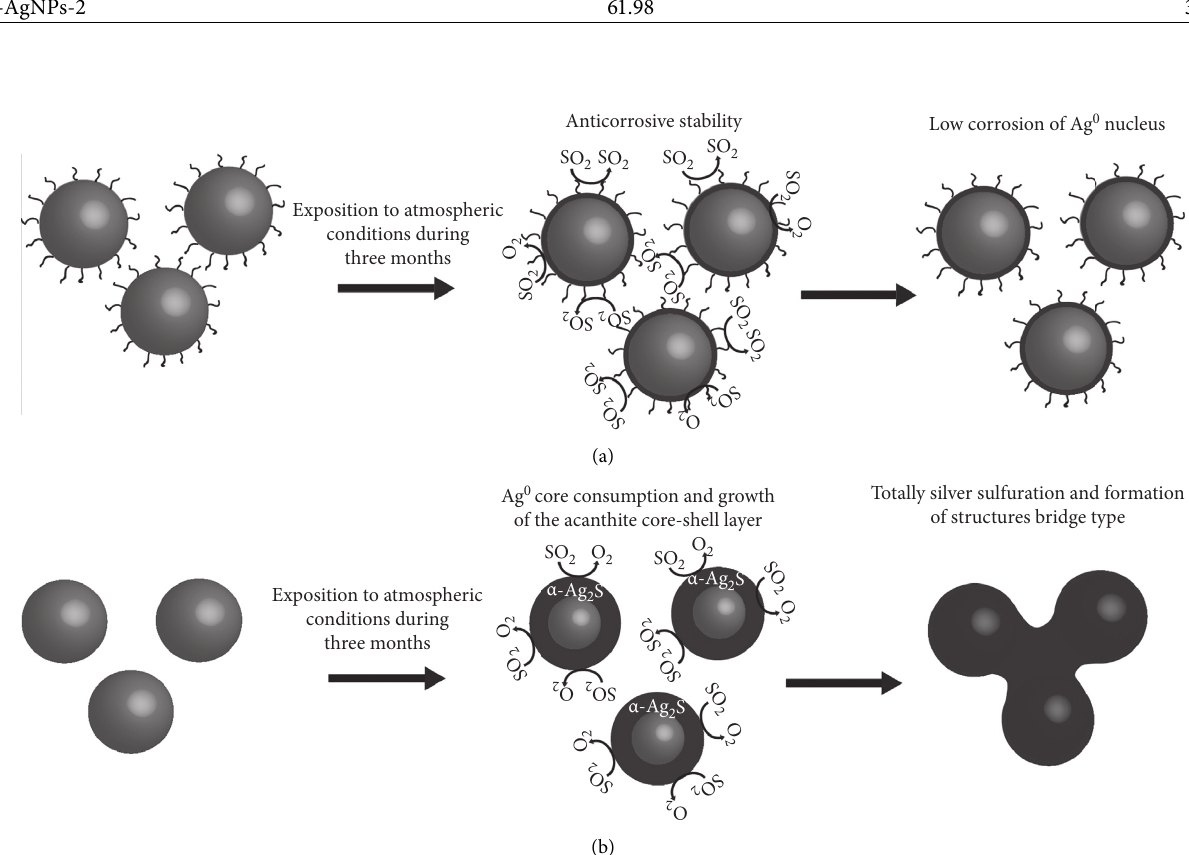
Figure 6: Schematic illustration showing (a) anticorrosive stability against sulfurs species present in the air of G-AgNPs and (b) sulfuration and instability of S-AgNPs to atmospheric